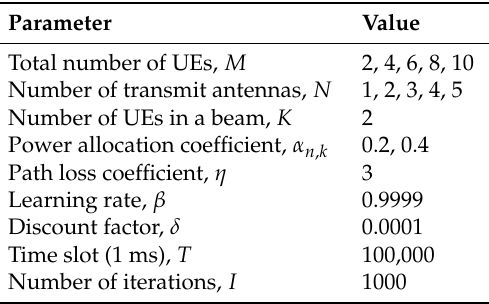
Table 2. Simulation